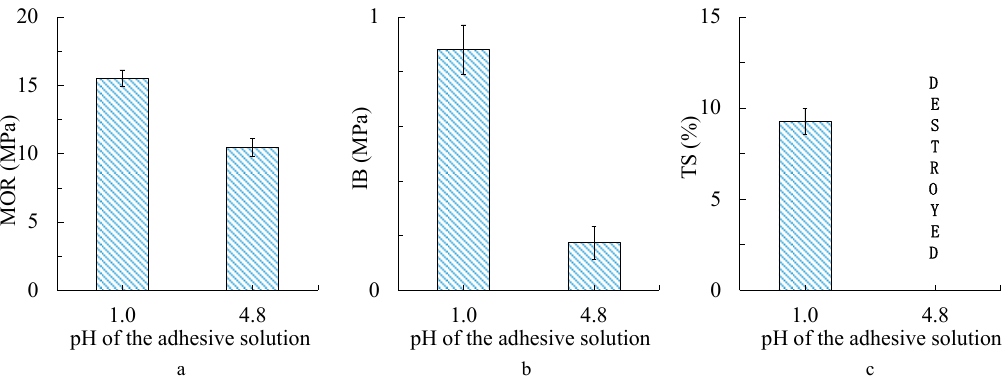
Figure 8. Mechanical properties and water resistance of the particleboards bonded by the tannin–sucrose–sulfuric acid adhesive (pH 1.0) and the tannin–sucrose adhesive (pH 4.8) at 180 °C for 10 min. ( a ) Bending properties; ( b ) internal bond (IB) strength properties; and ( c ) thickness swelling (TS) properties. MOR—modulus of rupture.